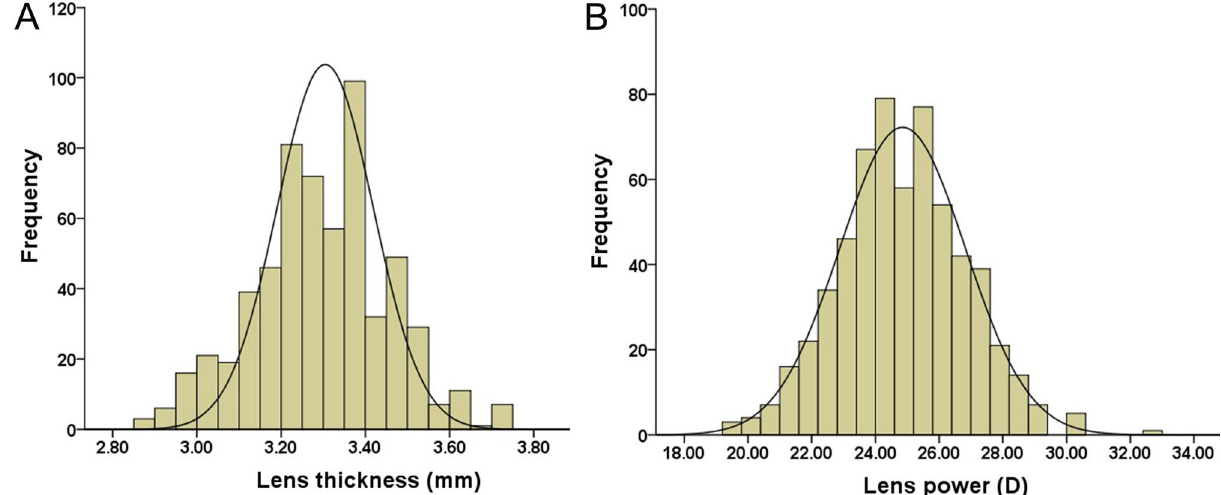
Figure 1. The distribution of lens thickness (A) and refractive lens power (B) in the right eyes of the study